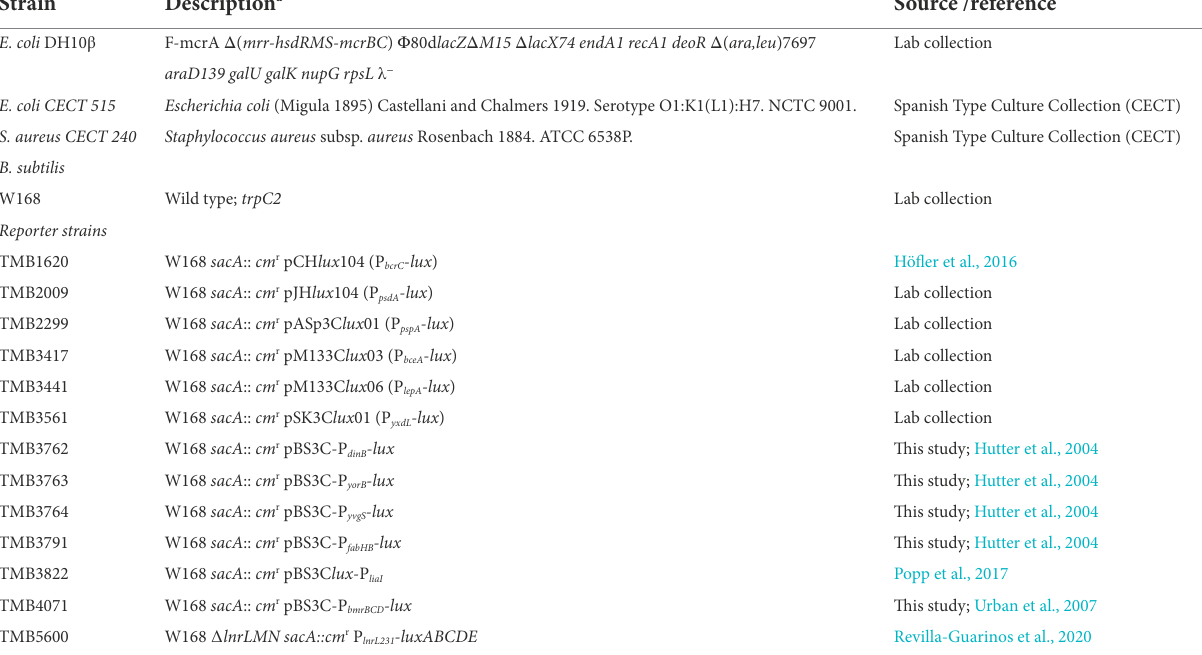
TABLE 3 Bacterial strains used in this study.